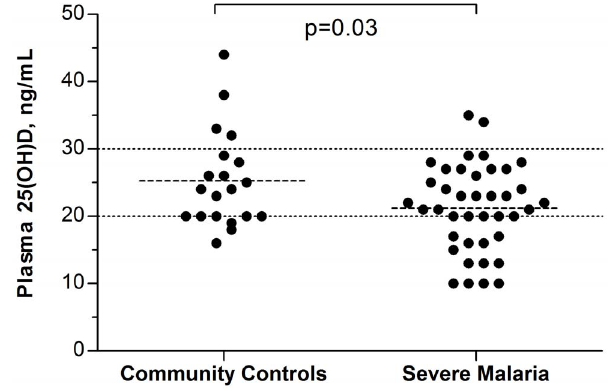
0.84, 1.0]. This relationship did not change after controlling for weight-for-age z- score [adjusted OR: 95% CI 5 0.91:0.83, 1.0] or weight-for-height z-score [adjusted OR: 95% CI 5 0.92:0.84, 1.0].